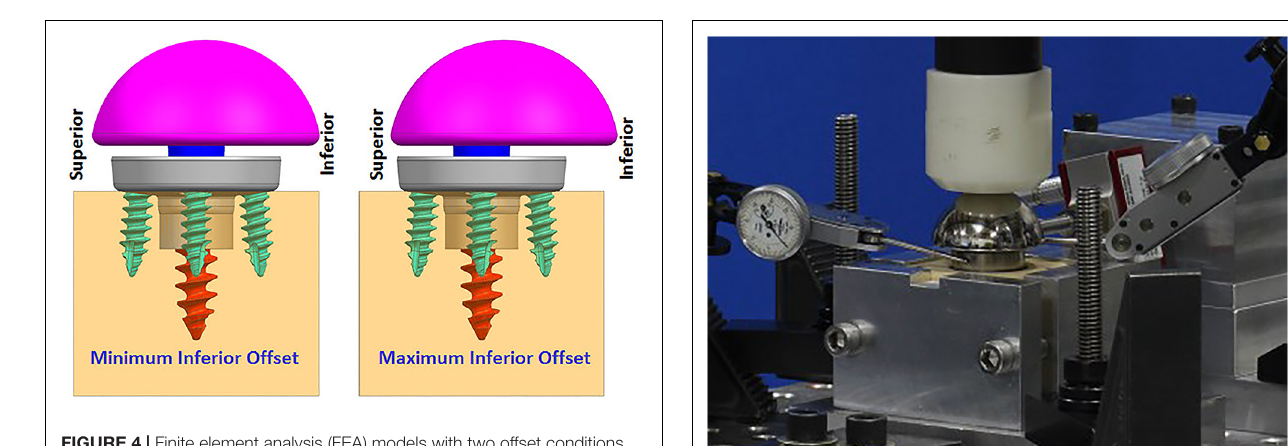
FIGURE 4 | Finite element analysis (FEA) models with two offset conditions (anterior–posterior view).